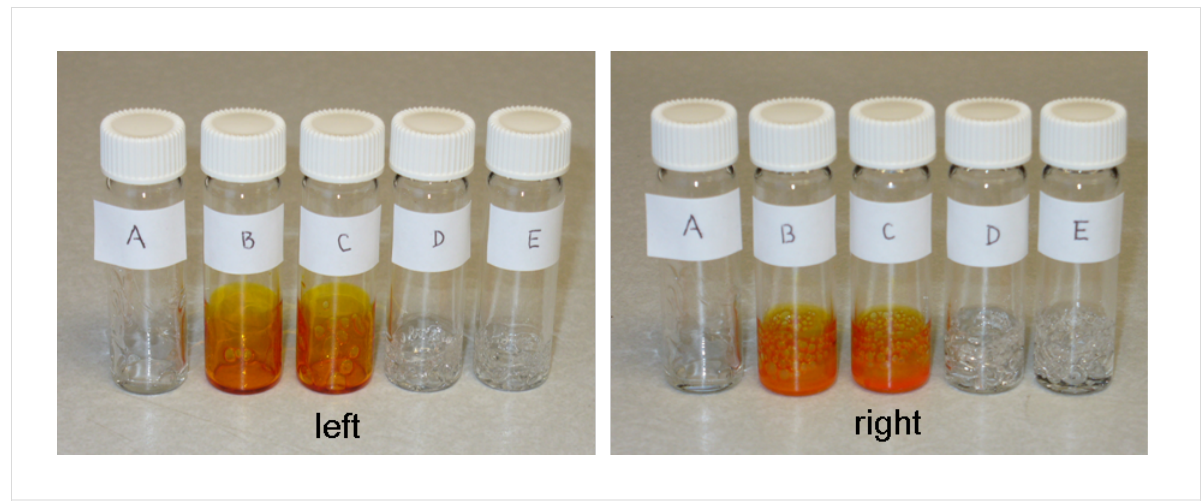
Figure 7: Color change after the interaction of azobenzene dye-coupled DAN modules with different UPy-modified PBA, followed by washing. Left: (A) PBA with compound 5 , (B) PBA-UPy (4.1 mol %) with compound 5 , (C) PBA-UPy (4.1 mol %) with compound 8 , (D) PBA-UPy (4.1 mol %) with compound 2 (E) PBA-UPy (4.1 mol %) with compound 15 . Right: (A) PBA with compound 5 , (B) PBA-UPy (7.1 mol %) with compound 8 , (C) PBA-UPy (7.1 mol %) with compound 10 , (D) PBA-UPy (7.1 mol %) with compound 2 , (E) PBA-UPy (7.1 mol %) with compound 15 .